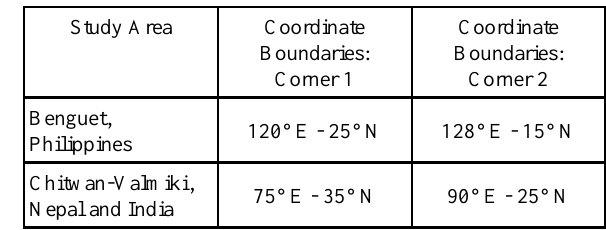
Table 3 . Geographical boundaries of study areas.